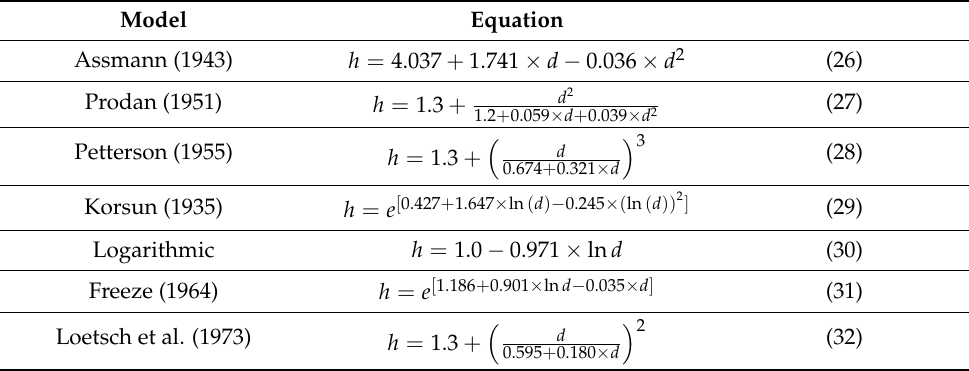
Table 4. Equations generated based on the coefficients shown in Table